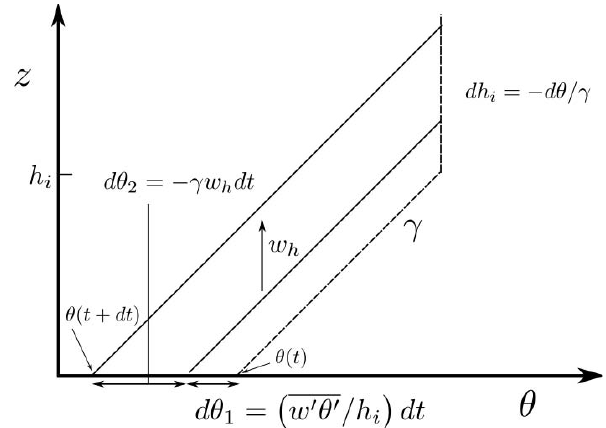
Fig. 3. The same as in Fig. 2, but for the the NBL. h i is the in- version height. d h i is the change in inversion height due to surface sensible cooling and upward motion. The temperature changes at the surface due to negative surface sensible flux and upward motion are indicated with d θ 1 and d θ 2 ,